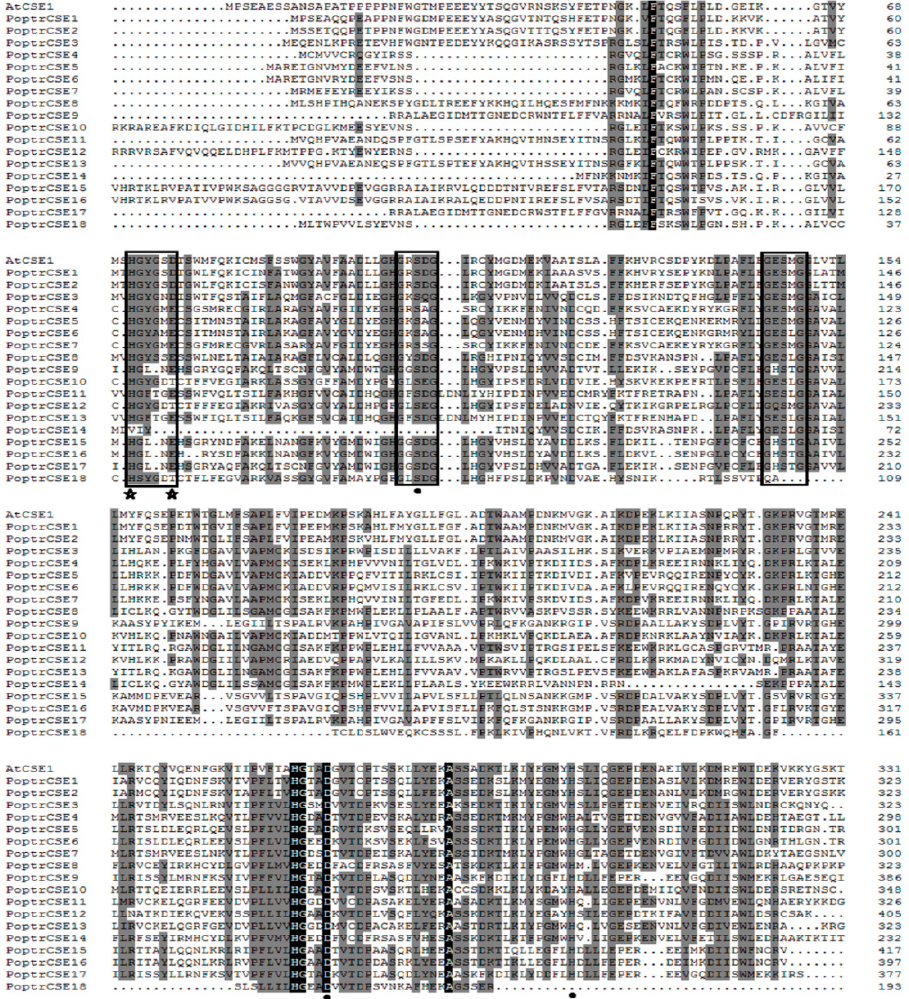
Figure 3. Alignment of eighteen putative PoptrCSE sequences with AtCSE1 (At1g52760). Conserved and functional motifs are indicated in black boxes, including an acyltransferase motif (HX 4 D) and two lipase/hydrolase motifs (GXSXG). Key amino acids involved in enzymatic activity are also marked with black stars (acyltransferase activity) or circles (catalytic triad).